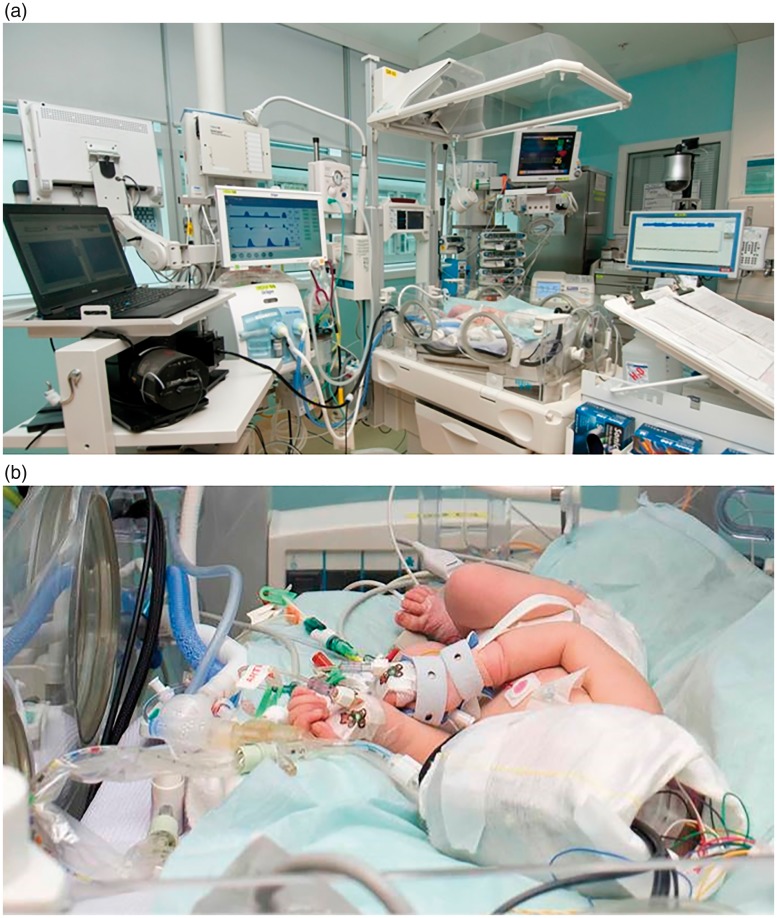
(a) Experimental set up demonstrating the integration of the
broadband NIRS system within the multimodal monitoring environment
in the NICU: broadband NIRS system is on the left with optical
fibres (black) entering the cot. (b) The baby in the cot being
monitored during treatment for HIE with broadband NIRS (black
optical fibre cables), EEG, transcutaneous monitors, blood pressure
catheter, respirator and ECG.